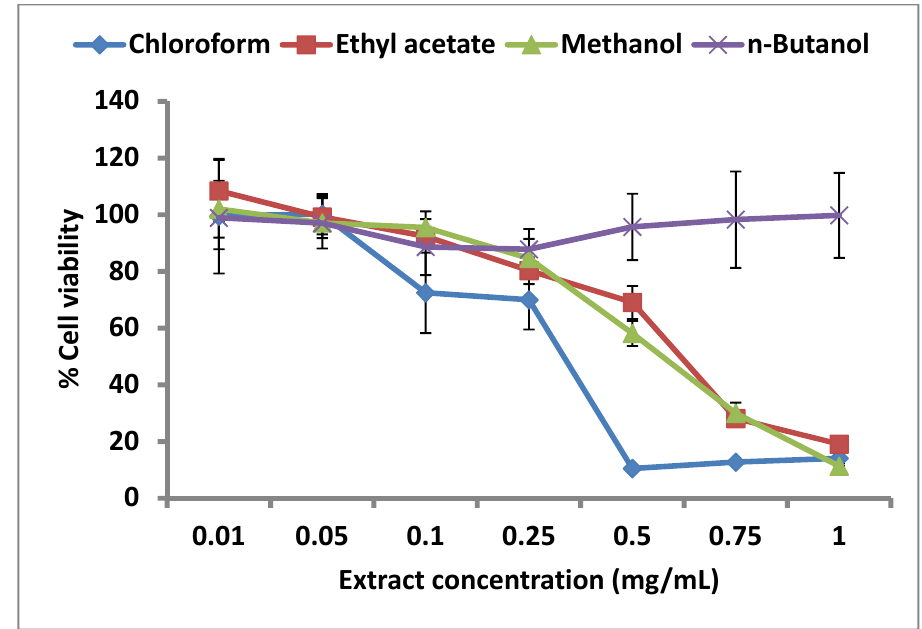
Figure 3. Cytostatic effect of C. lucidus extract on PaCa-2